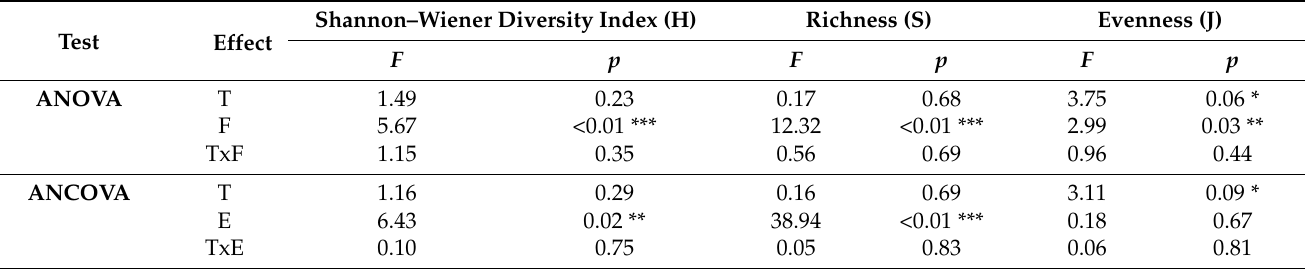
Table 8. Analysis of variance (ANOVA) and analysis of covariance (ANCOVA) for overstory Shannon– Wiener diversity index (H), richness (S) and evenness (J). Results include F -statistic ( F ) and p -values ( p ) for the parameters. Facility establishment date (E) was used as the ANCOVA covariate.